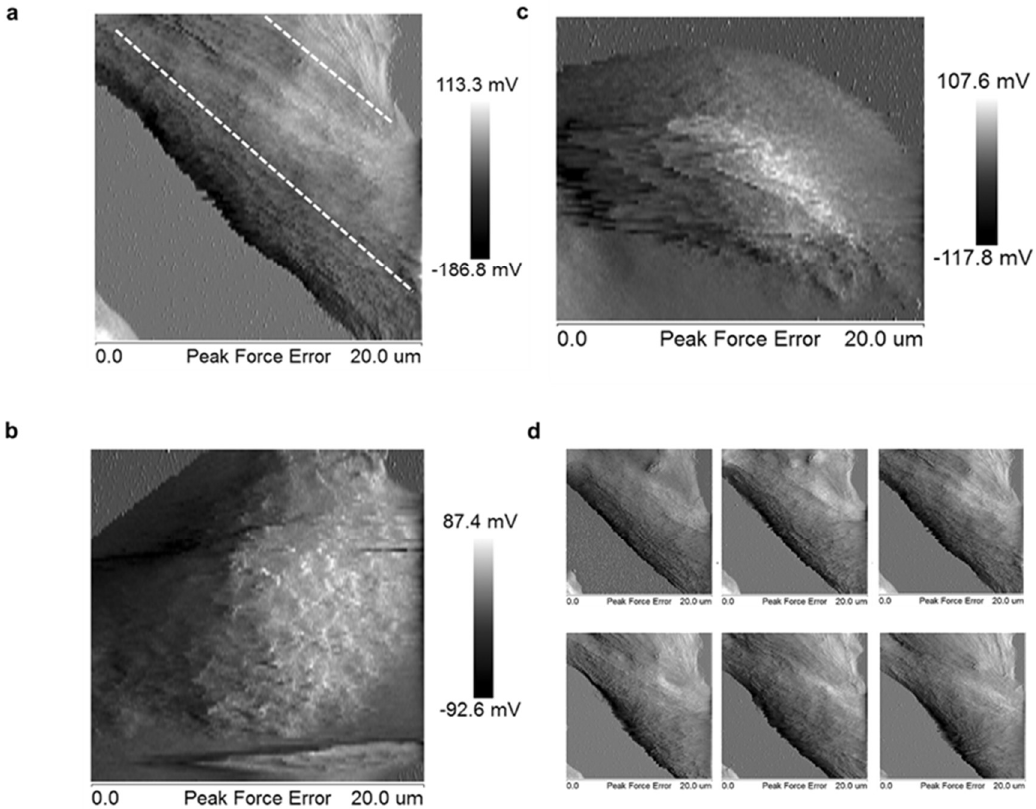
Figure 3. Loss of organized cell surface structure in me_HR-transformed mesenchymal stem cells (MSCs). Cell surface morphology of MSCs ( a ), me_HR-transformed MSCs ( b ), and 5-aza-2′-deoxycytidine-treated me_HR-transformed MSCs ( c ) were measured through AFM. The peak force error moduli are shown in black and white after being transformed using NIH Image and enlarged at the same proportion to highlight the surface spines. Dashed lines indicate the orientation of the organized cell surface structures. ( d ) Sequential peak force errors of the same MSCs cells were correlated with cell movement.